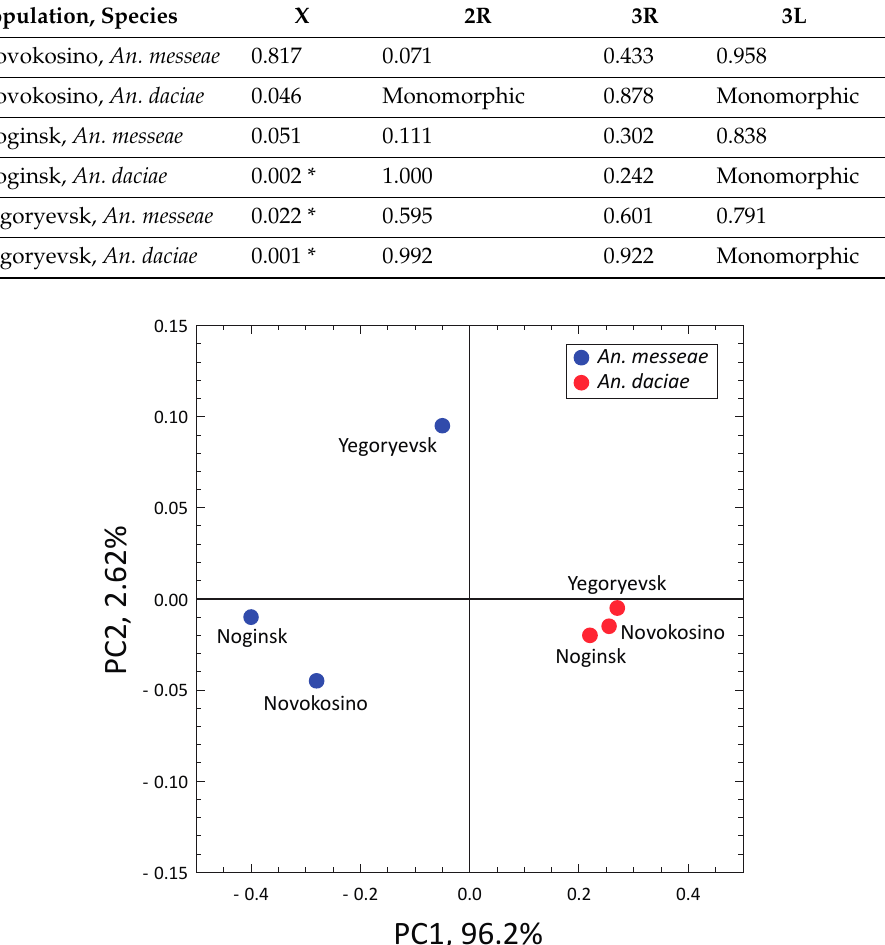
Table 3. Pairwise Fst values between the studied populations of An. messeae and An. daciae based on the frequency of autosomal arrangements. *—results are significant with α < 0.05 after applied Bonferroni correction.